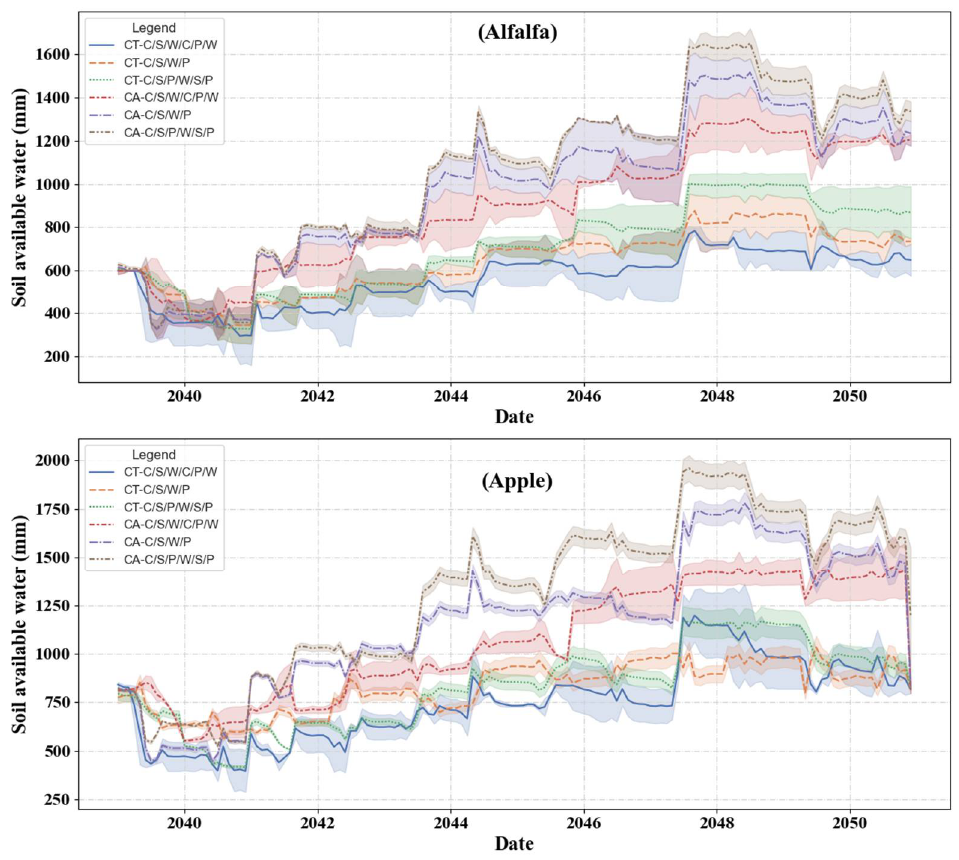
Figure 8. Soil water content (cm 3 cm −3 ) profiles of the 0–15 m in conventional tillage and conservation agriculture.